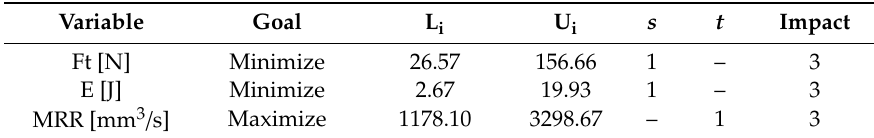
Table 6. Values considered in the desirability